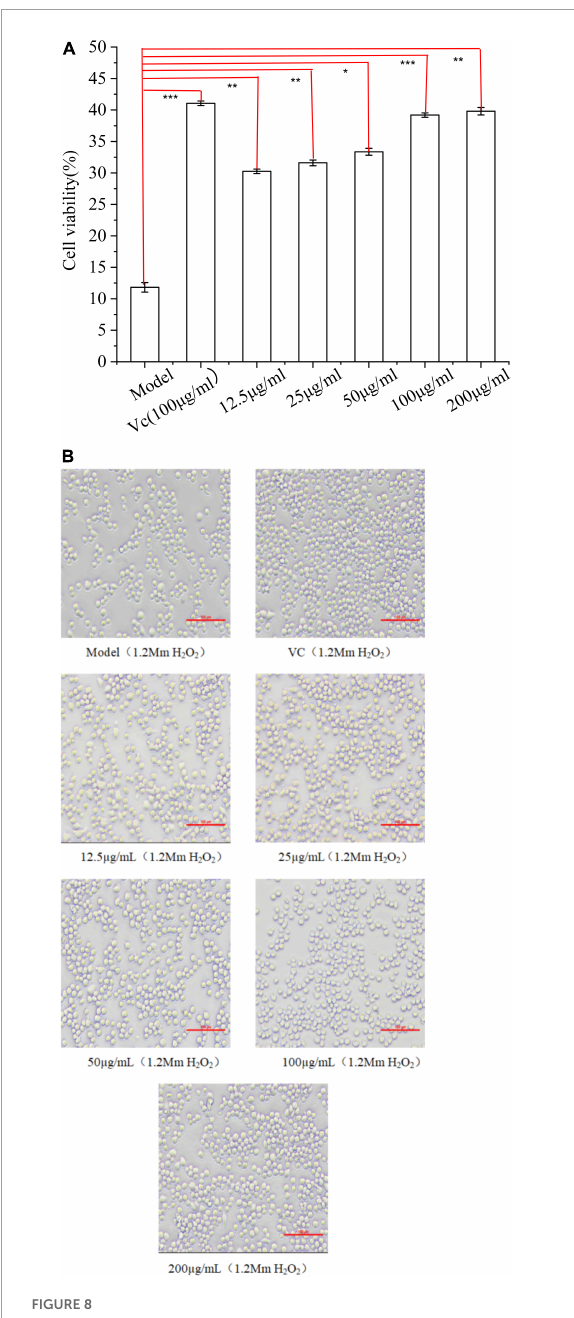
FIGURE8 (A) Effect of EFP-2 on the survival rate of RAW264.7 cells with H 2 O 2 -induced injury; (B) comparison of the differences in morphology and number of RAW264.7 cells with H 2 O 2 -induced injury at different EFP-2 concentrations. Significant differences with model group were designated as * P < 0.05, ** P < 0.01, *** P <